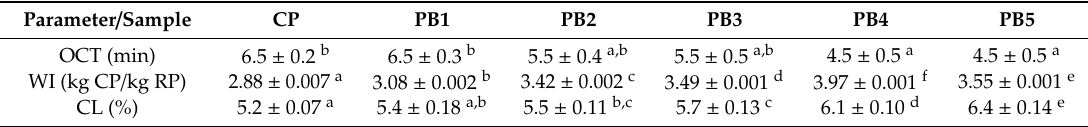
Table 5. Results for cooking properties of pasta samples.